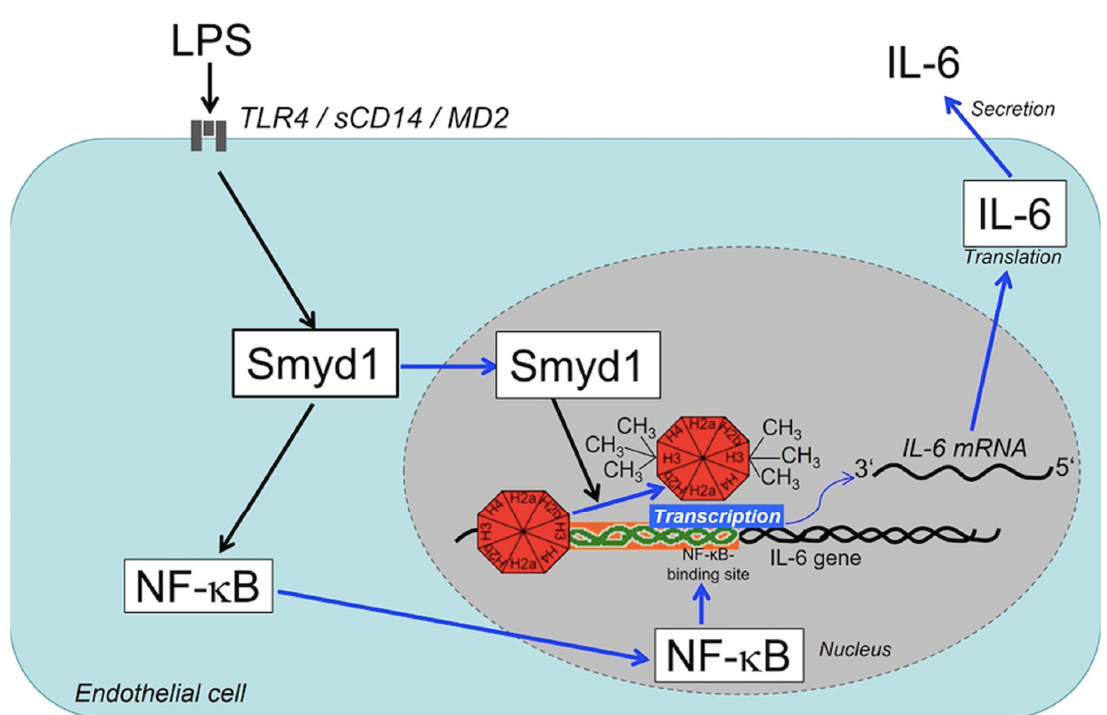
Figure 7. Schematic summary of the molecular model deduced from the experimental findings of this study. By binding to its specific receptor complex on the cell surface, LPS induces an up-regulation of Smyd1 in ECs. The corresponding intracellular increase of Smyd1 levels results in the activation of two signaling cascades. (1) More Smyd1 presence in the cytoplasm causes more frequent translocation of Smyd1 molecules into the cell nucleus. Enrichment of the methyltransferase Smyd1 in the nucleus results then in trimethylation of lysine 4 in histone 3 (H3K4me3) at region2 of the IL-6 promoter. This epigenetik modification leads to better accessibility of the promoter for the RNA polymerase transcription complex, so that the IL-6 transcription rate is increased. 2. More Smyd1 presence in the cytoplasm accompanied by I κ B α down-regulation also up-regulates NF- κ B expression leading to a larger cytoplasmic NF- κ B pool. Subsequently, more NF- κ B molecules diffuse into the nucleus, where NF- κ B binds to a specific site within the promoter sequence (green-orange) of the IL-6 gene. As a consequence of the double activation of the promoter region, IL-6 transcription, as well as subsequent translation and secretion of the IL-6 protein, are accelerated resulting in higher IL-6 bioavailability. Black arrows indicate up-regulation, while blue arrows stand for intracellular transport.